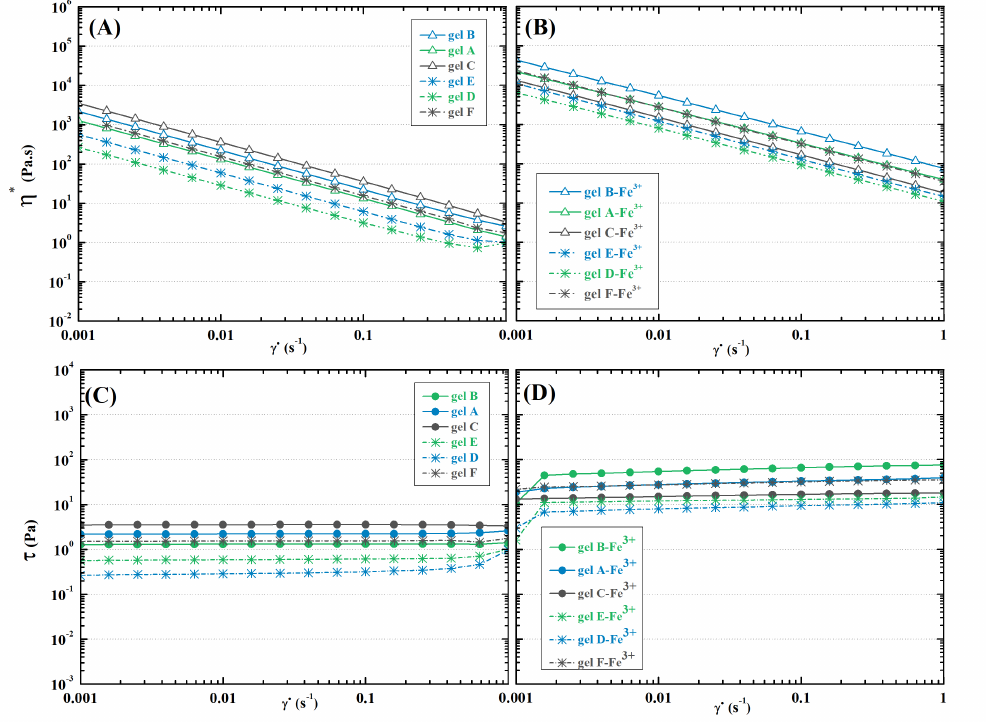
Figure 7. Rheological characterisation of the hydrogels: ( A ) Complex viscosity–shear rate curves of Schiff base cross-linked and ( B ) dually cross-linked hydrogels; ( C ) Shear stress–shear rate curves of Schiff base cross-linked and ( D ) dually cross-linked